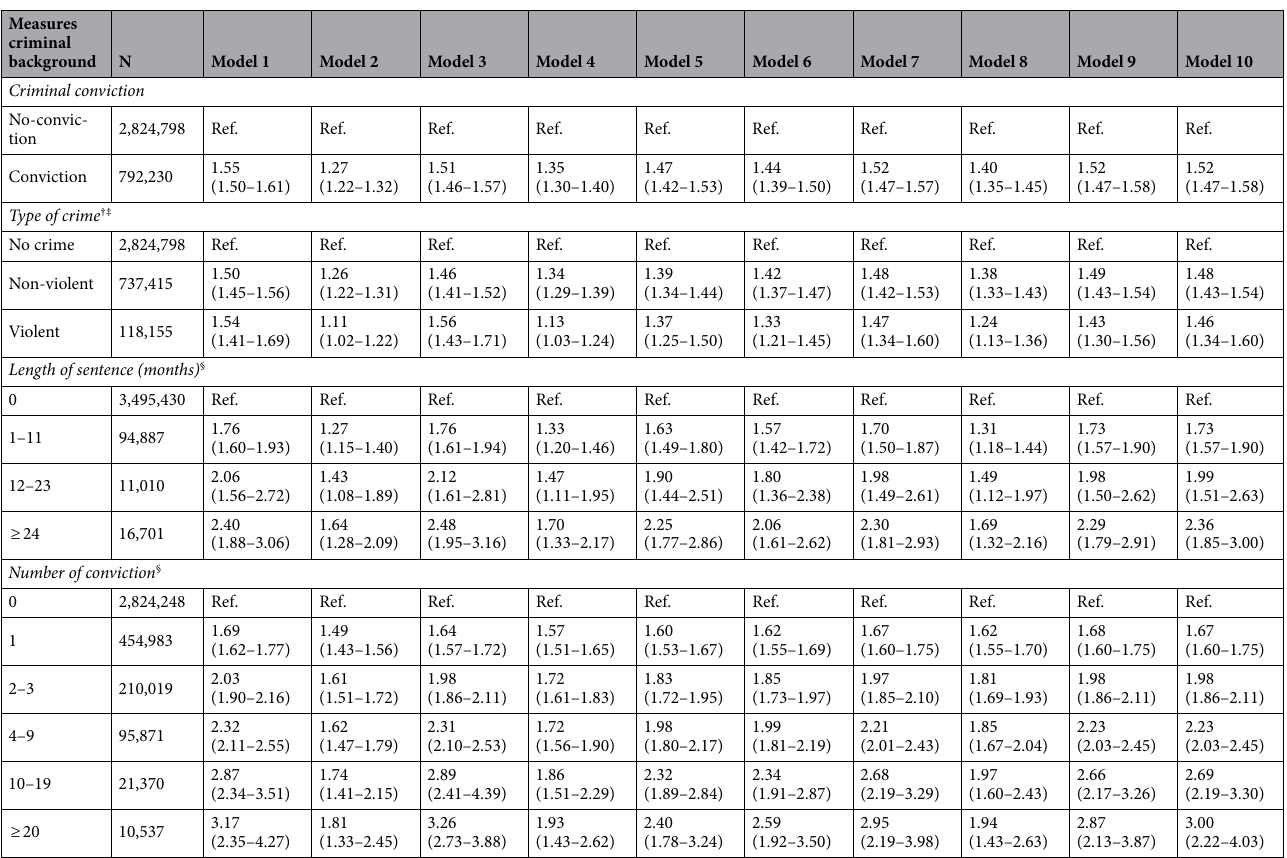
2.87 Table 4. Association between the four measures for the criminal background and mild cognitive impairment (MCI) as hazard ratios (HR) with 95% confidence intervals (CI). Model 1: HR (95% CI) adjusted for sex and birth year. Model 2: Full Adjustment for all covariates. Model 3: HR (95% CI) adjusted for sex and birth year and educational attainment. Model 4: HR (95% CI) adjusted for sex and birth year and mental health disorders. Model 5: HR (95% CI) adjusted for sex and birth year and physical health disorders. Model 6: HR (95% CI) adjusted for sex and birth year and depression. Model 7: HR (95% CI) adjusted for sex and birth year and anxiety. Model 8: HR (95% CI) adjusted for sex and birth year and substance use disorder. Model 9: HR (95% CI) adjusted for sex and birth year and schizophrenia spectrum disorders. Model 10: HR (95% CI) adjusted for sex and birth year and bipolar disorder. N Number of individuals. † Type of crime is a time-varying exposure. ‡ Type of crime: Individuals with convictions can contribute to both non-violent and violent types of crime. § Number of convictions and Length of the sentence are time-fixed exposures showing the total number of convictions or sentence months in the individual´s lifetime.